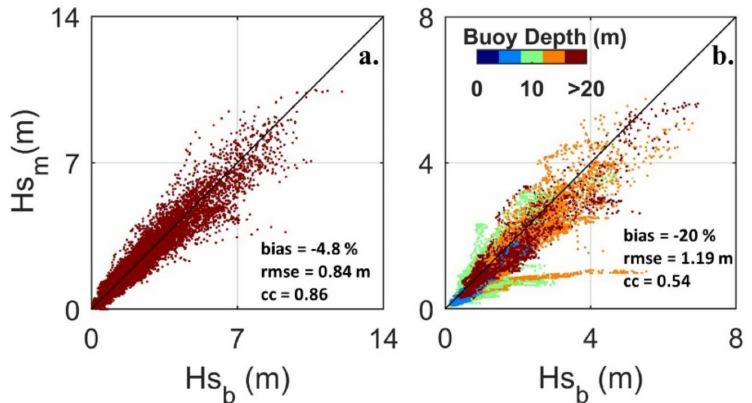
Figure 5. Comparison plots of buoy significant wave height (Hs b ) to NCEP simulated significant wave heights (Hs m ) for ( a ) buoy depths greater than 20 m and ( b ) less than 20 m. Error metrics were provided for each plot for Hs > 3